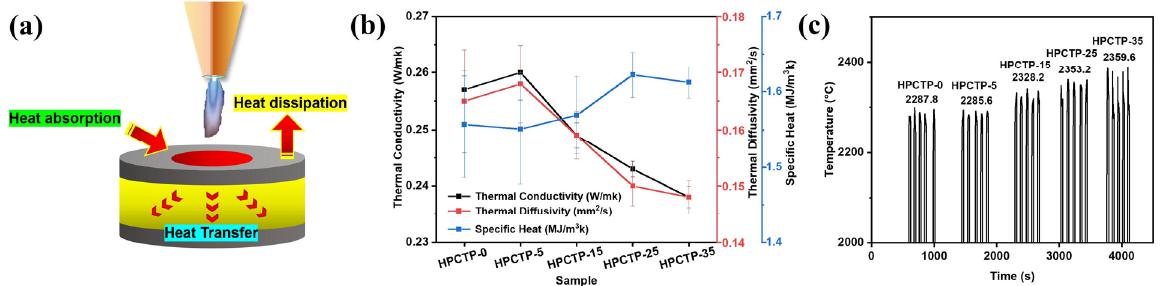
Figure 3. HPCTP-modified EMVSR composites: ( a ) schematic diagram of heat loss, ( b ) thermal conductivity, thermal diffusivity, and specific heat curves, ( c ) surface temperature curve of ablated samples.